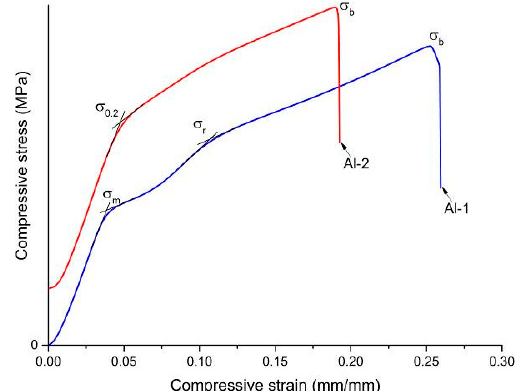
Figure 4. Stress–strain curves (schematic) for alloys with and without martensitic transformation (Al-1 and Al-2 correspondently).